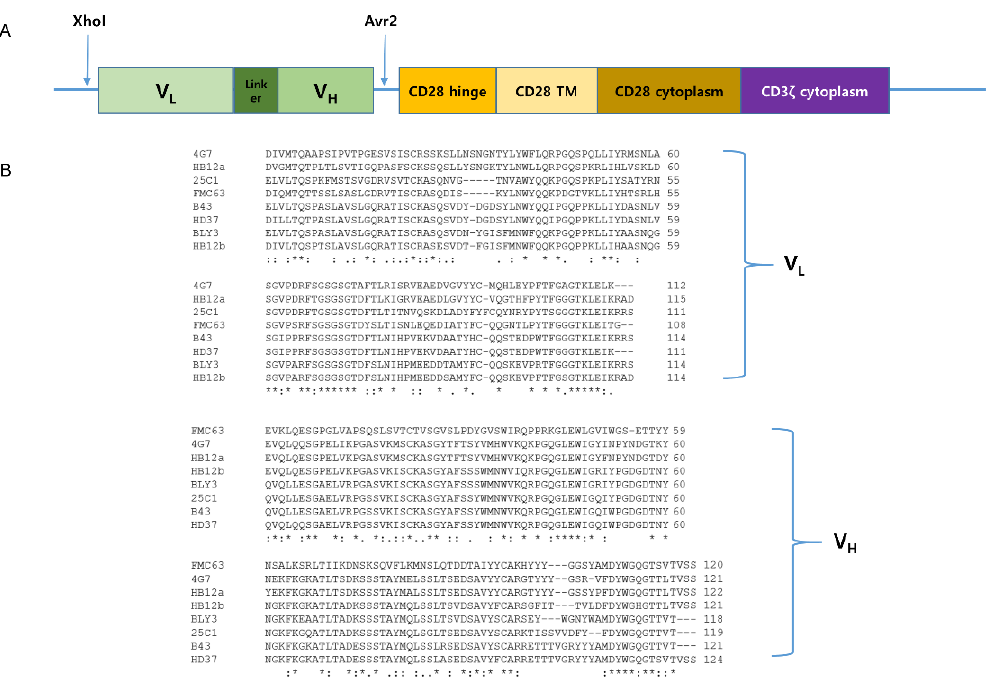
Figure 2. CAR constructs of various scFvs capable of targeting CD19. ( A ) Schematic representation of anti-CD19 CAR construct. It is a second-generation CAR composed of anti-CD19 scFv, CD28 transmembrane region, CD28 co-stimulatory domain, and CD3 ζ signaling domain. ( B ) V H and V L sequences of eight different anti-CD19 scFvs.